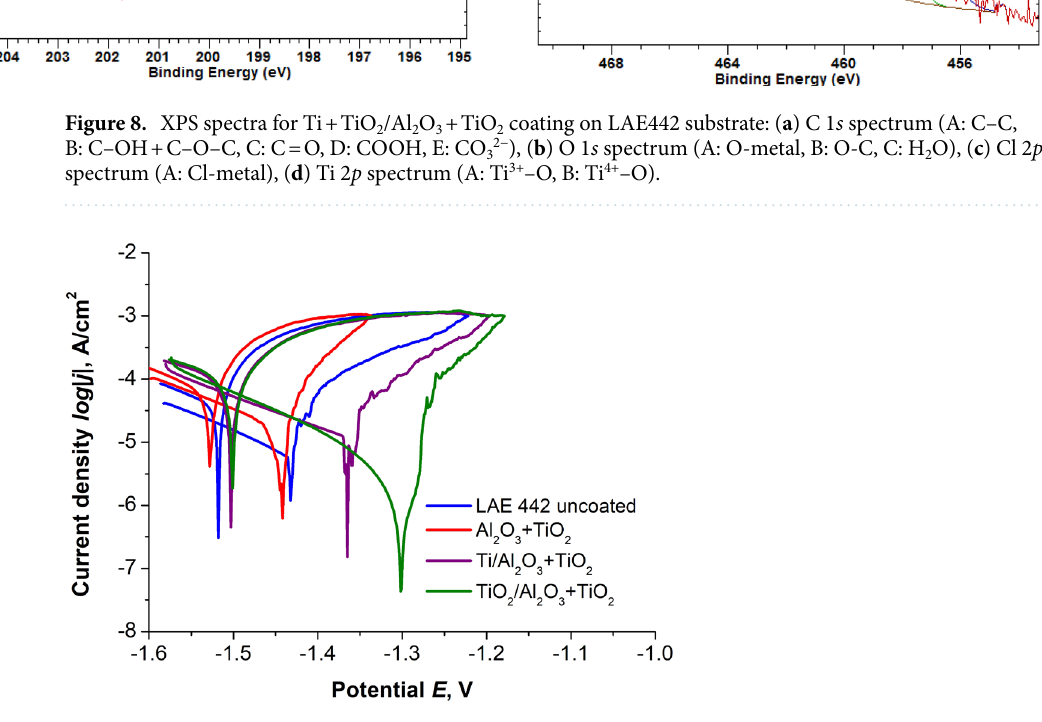
Figure 9. Potentiodynamic polarisation curves for uncoated and coated LAE442